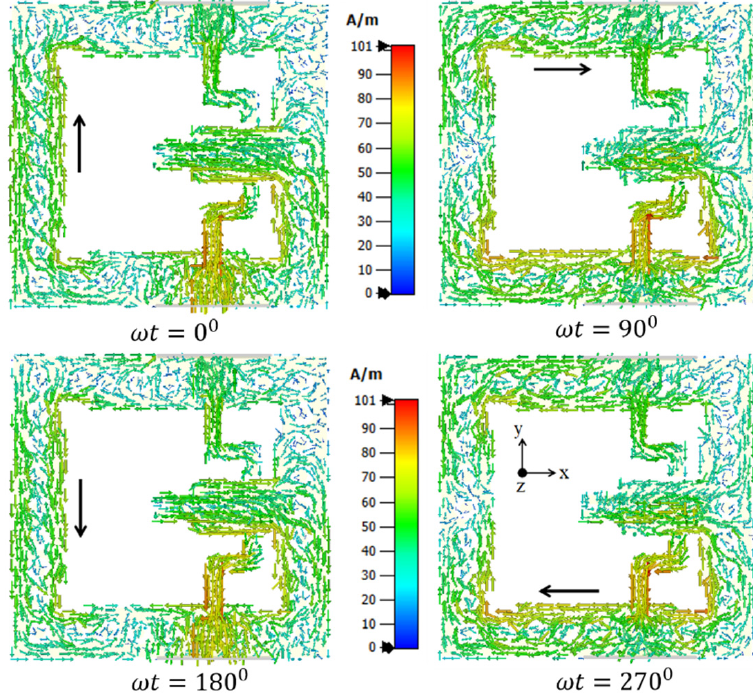
Figure 21. Surface current density at 5.45 GHz [71].